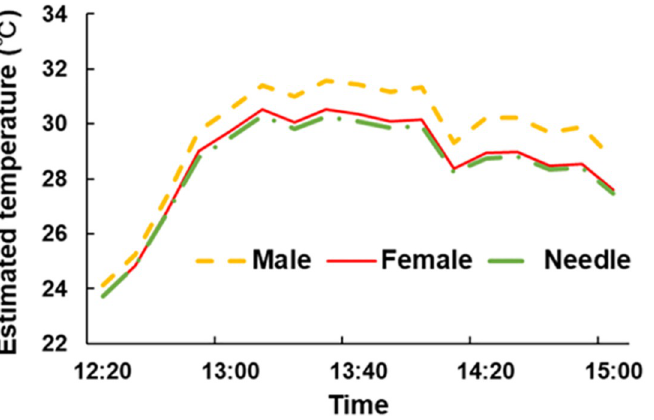
Fig 11. Estimated temperature of WCSBs on different plant organs. This estimation was conducted using environmental data measured on 1 April 2021.